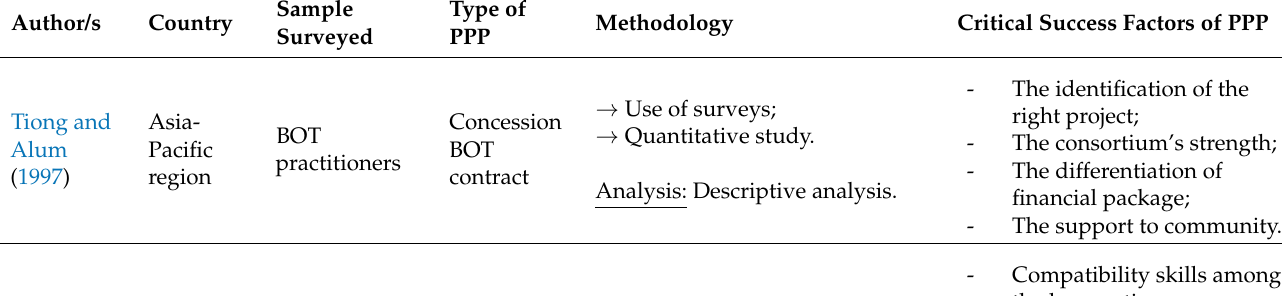
Table 1. Literature Review